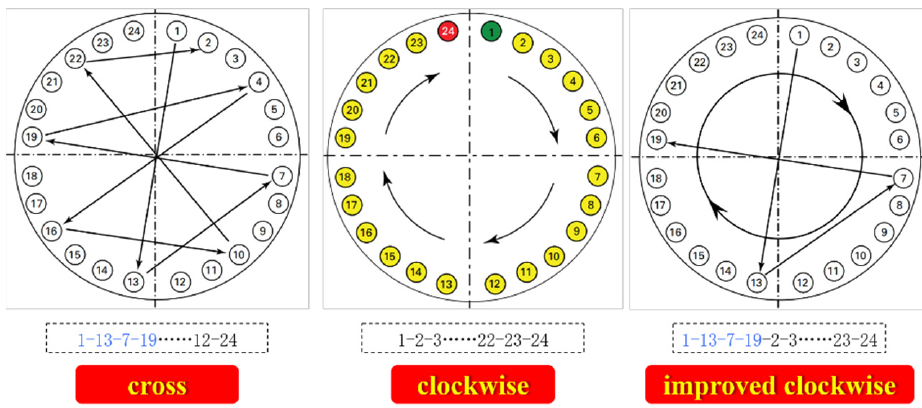
Figure 11. Brief diagram of the three tightening methods.